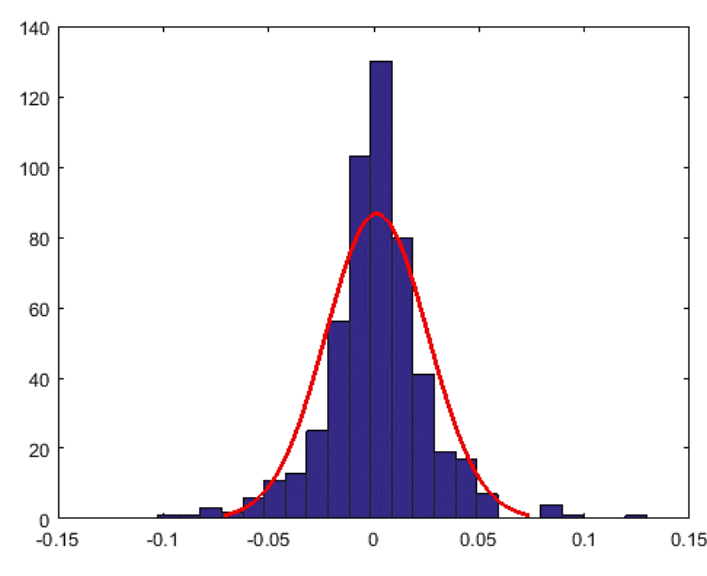
Figure.3. The histogram and normal density of log-return WHGS3 price from 2010 to